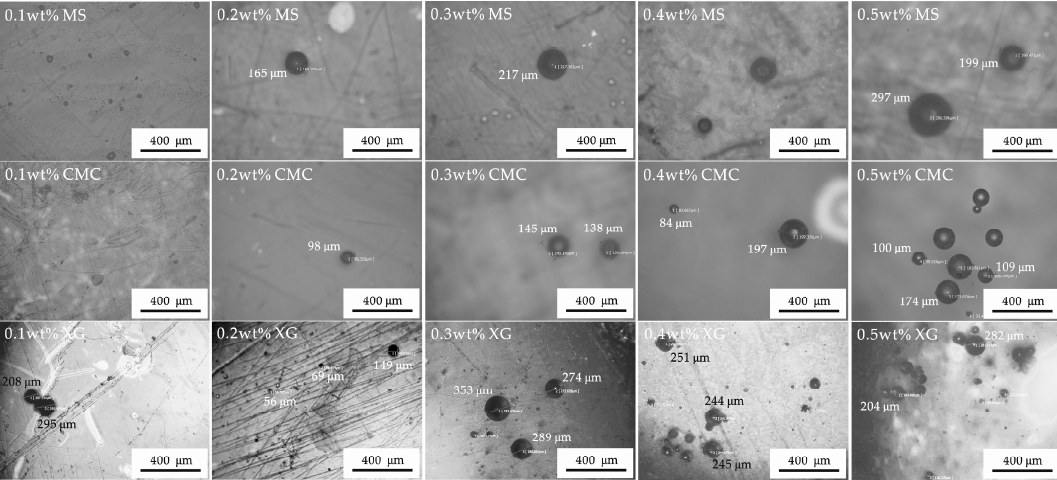
Figure 6. Retention of bubbles after solution transfer in each experiment. MS: modified starch, CMC: carboxymethylcellulose sodium, XG: xanthan gum.